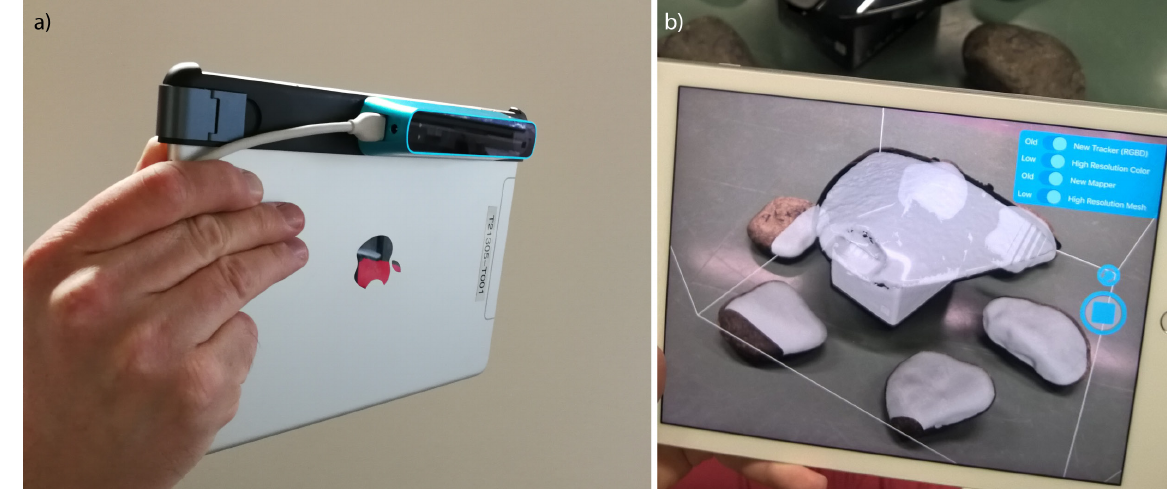
Figure 1: The Structure Sensor mounted on an iPad (a) and the user interface of the scanning application, showing the camera view overlaid with the obtained mesh (b).